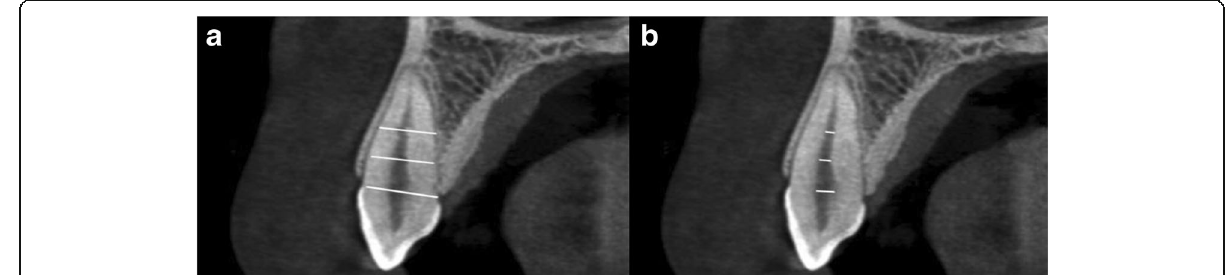
Fig. 3 a , b Pulp to root width ratio at cementoenamel junction level and mid-root level and midpoint between the cementoenamel junction and the mid-root in cross section image